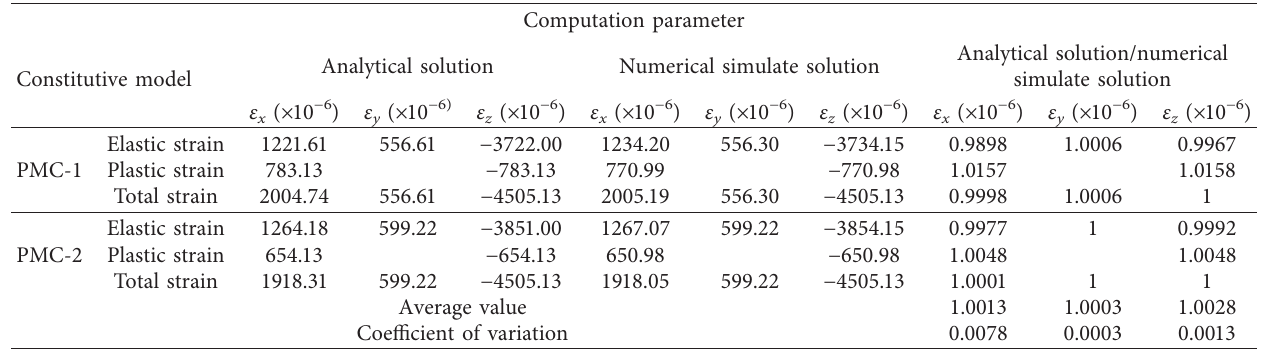
Table 5: Comparison table of numerical simulation results of the true triaxial